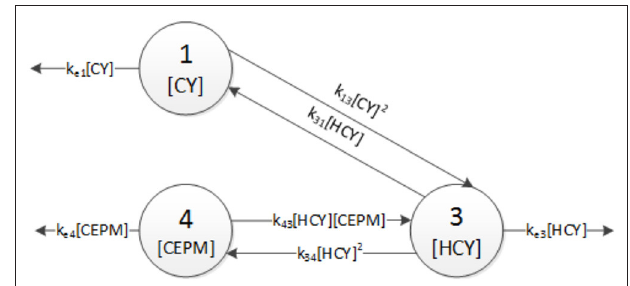
FIGURE 5 | Compartmental model with seven unknown